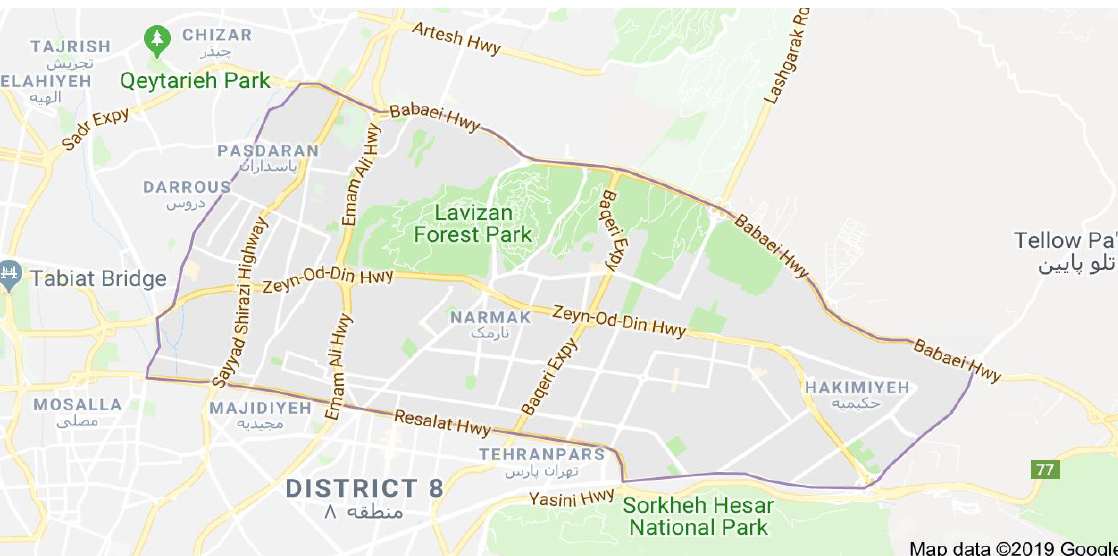
Fig. 3. Display the Tehran area 4 on the map of Google